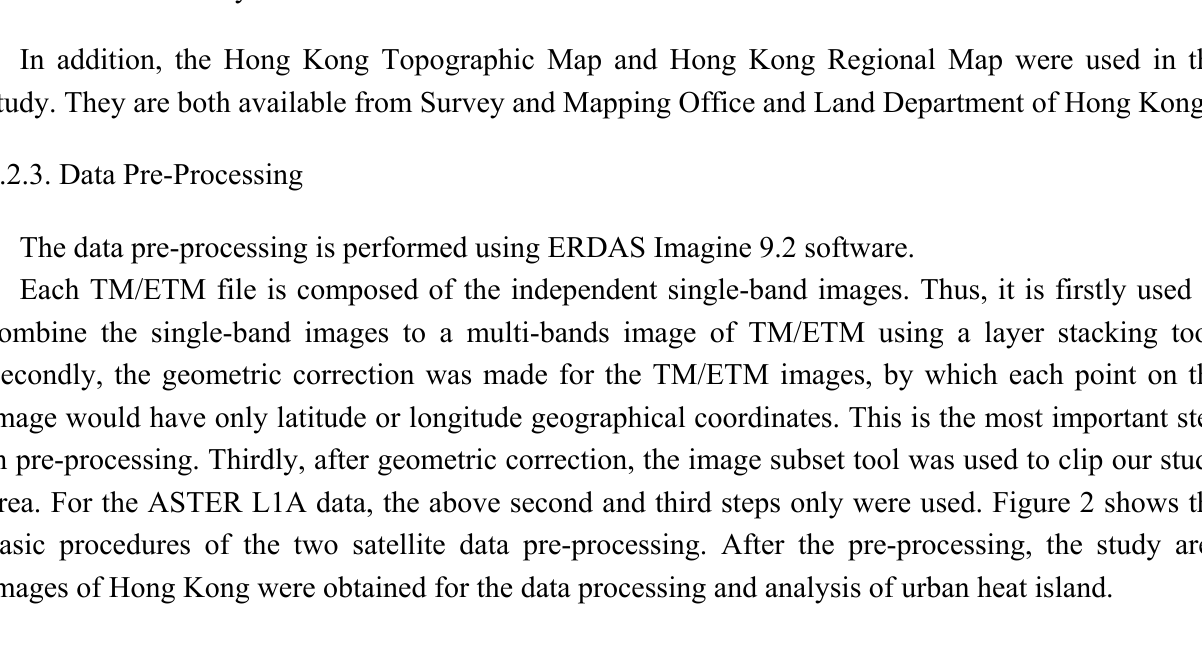
Figure 2. The data pre-processing